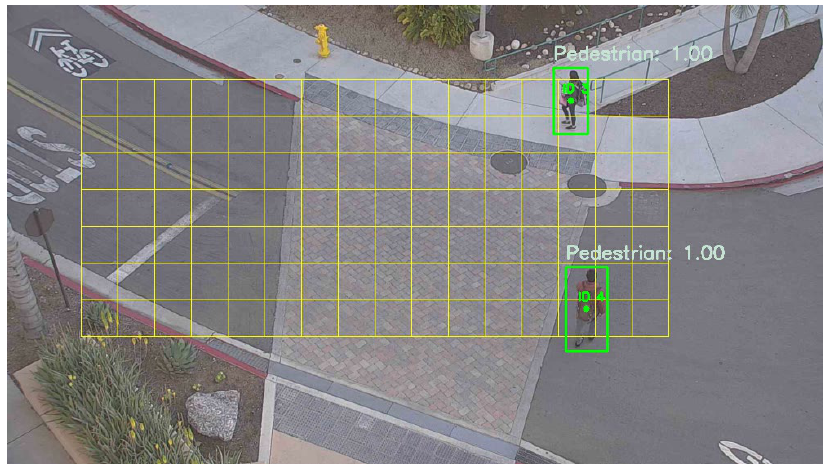
Figure 26. Two pedestrians inside the grid with unique registered